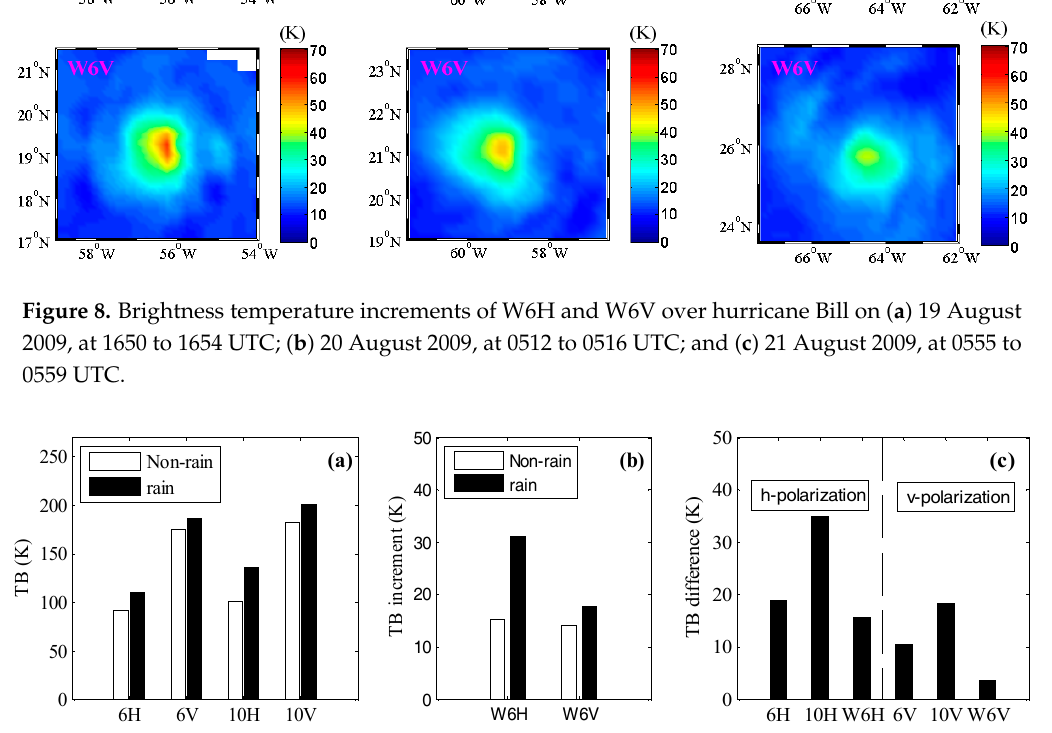
Figure 8. Brightness temperature increments of W6H and W6V over hurricane Bill on ( a ) 19 August 2009, at 1650 to 1654 UTC; ( b ) 20 August 2009, at 0512 to 0516 UTC; and ( c ) 21 August 2009, at 0555 to 0559 UTC.